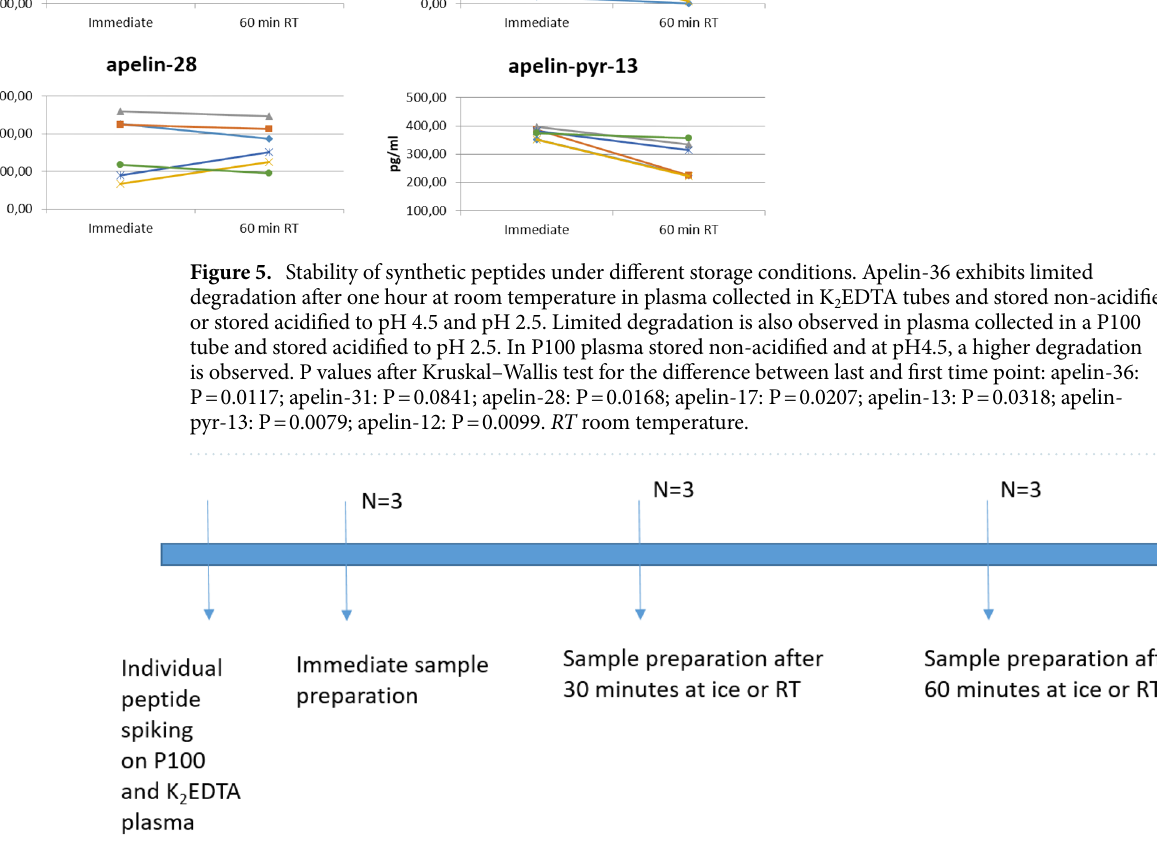
Figure 6. Overview of testing influence of P100 tubes on peptide stability. To test whether the P100 tube protease inhibitor cocktail results in additional peptide stability before blood tubes centrifugation, we spiked apelin-36, -17, -13, -pyr-13 and -12 on K 2 EDTA and P100 plasma. The samples were measured immediately, or after 30 and 60 min on ice or at room